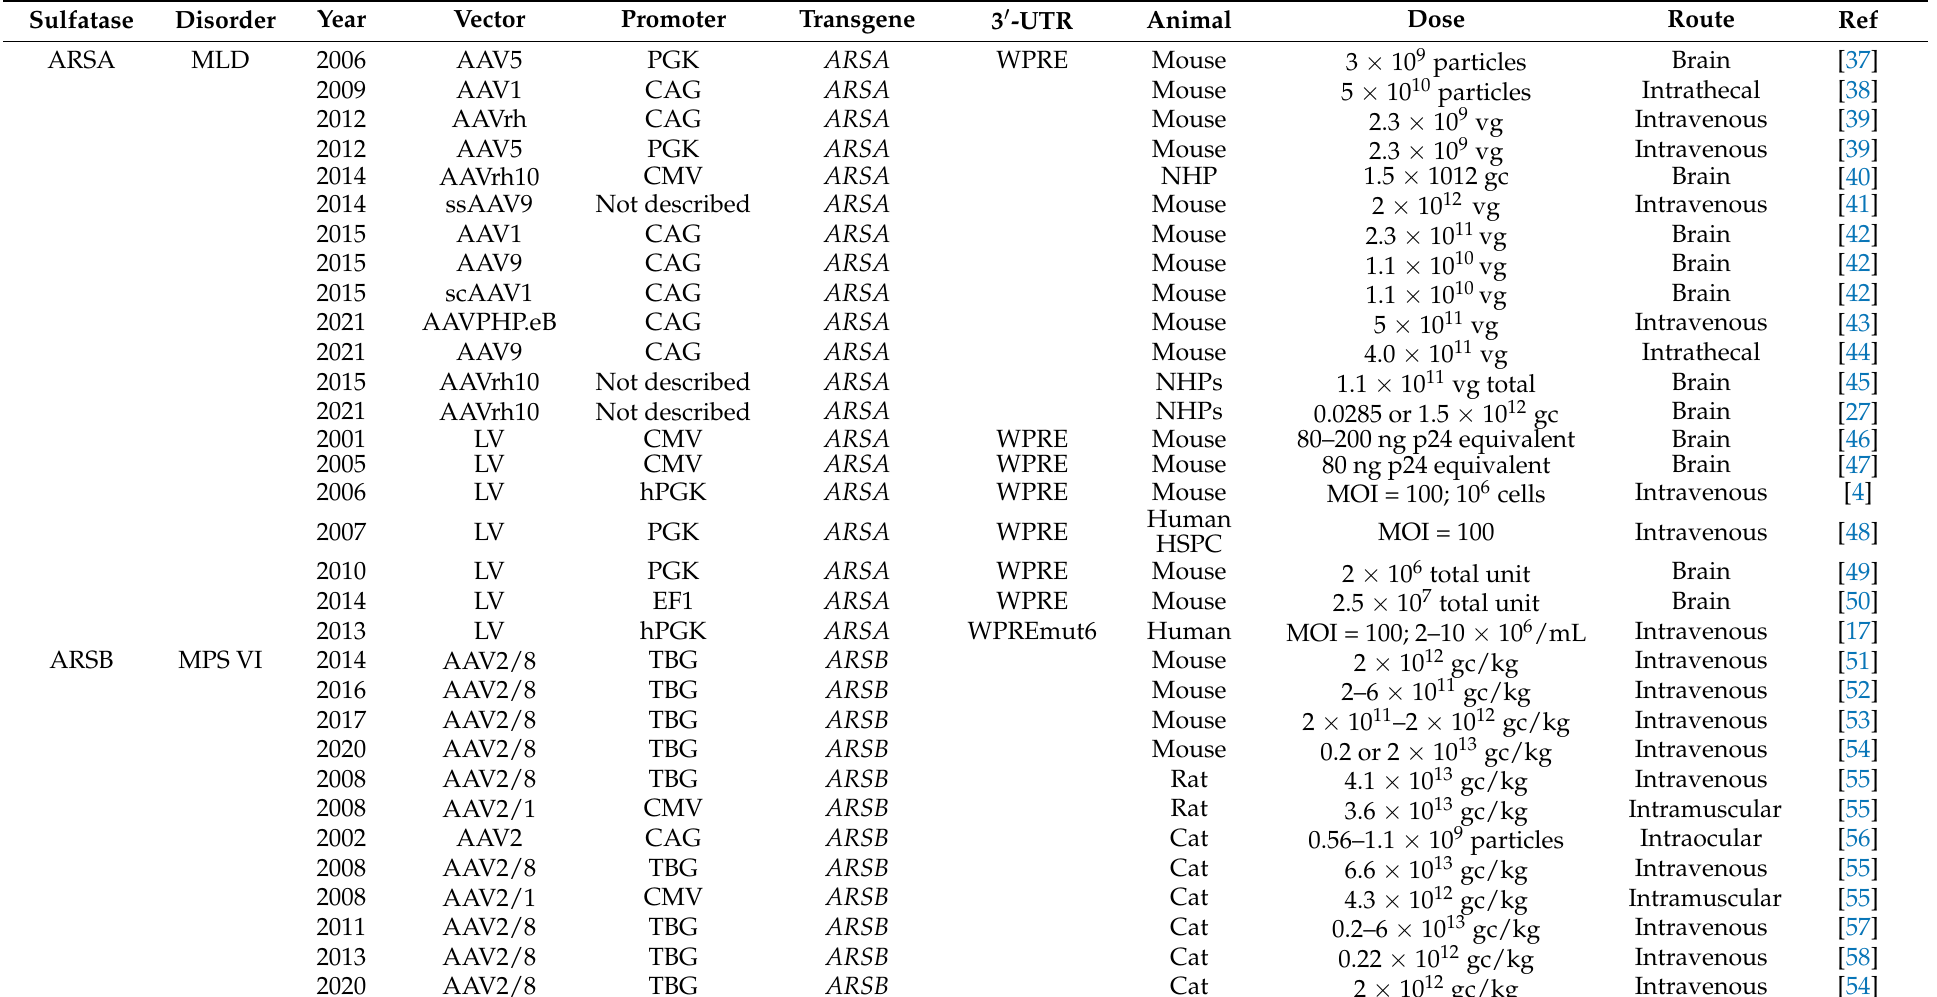
Table 3. Vectors used for the study of sulfatase gene